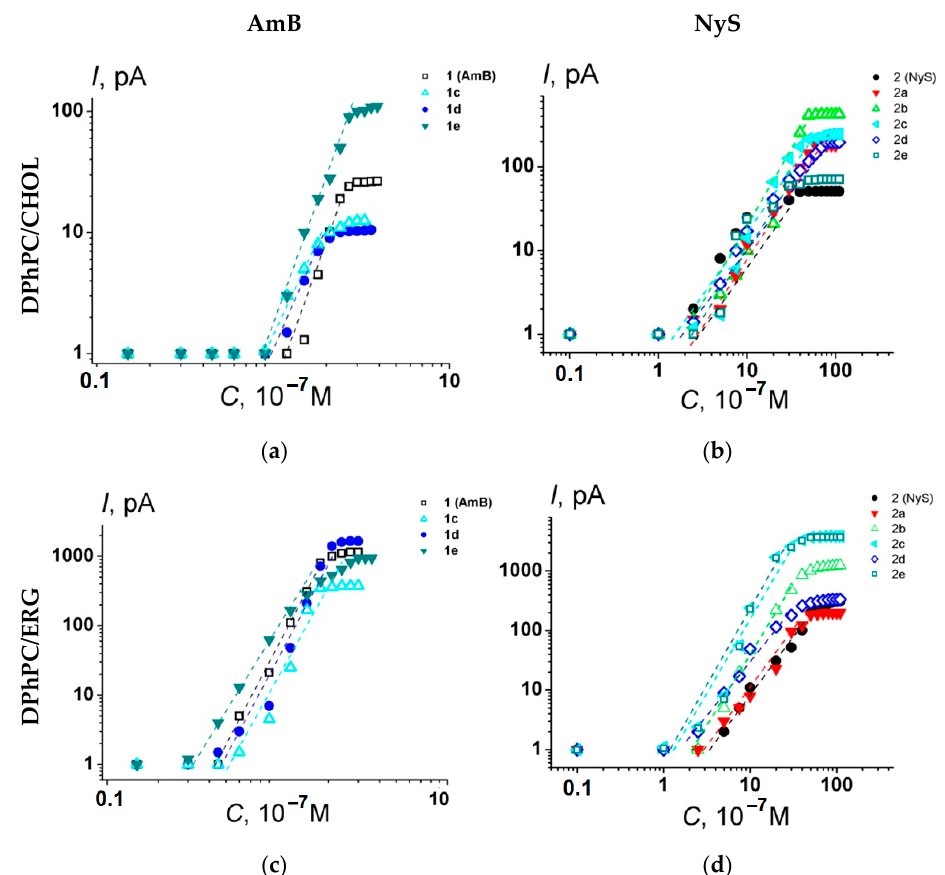
Figure 6. Bilogarithmic dependence of the steady-state polyene-induced transmembrane current on the concentration of AmB ( a , c ) and Nys ( b,d ) derivatives in the bilayer bathing solution. The trans- membrane voltage was equal to 100 mV. Membranes were composed of DPhPC/CHOL (67/33 mol %) (upper panel) and DPhPC/ERG (67/33 mol %) (lower panel) and bathed in 2.0 M KCl (pH 7.4). The relation between the color symbol and the compound is given on the figure. Table 5. The characteristic parameters of the dependences of macroscopic ionic conductance induced by different AmB and Nys derivatives in CHOL- and ERG- enriched bilayers on the concentration of polyenes. Polyene C CHOL 1 , 10 − 7